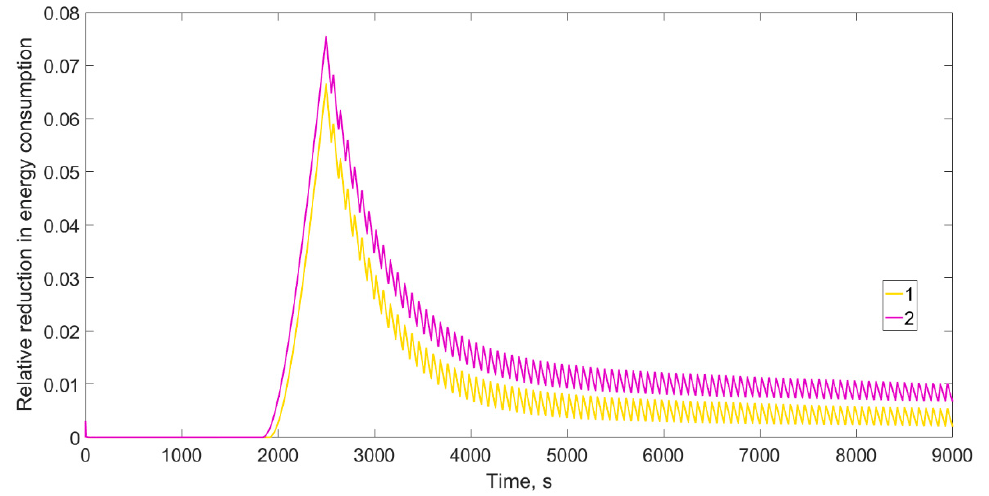
Figure 16. Course of the relative decrease in energy usage for control systems without noise 1—(relay–PID) and 2—(relay—I-PD).